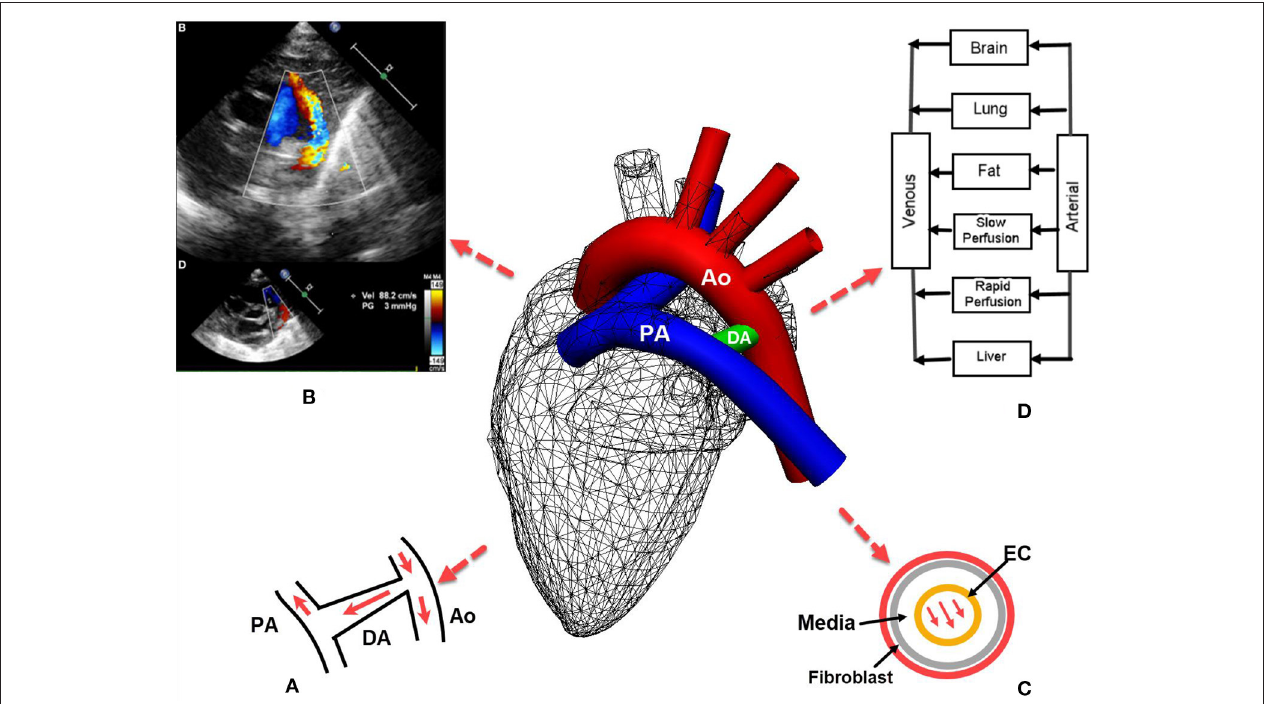
FIGURE 1 | Patent ductus arteriosus (PDA) in preterm infants: (A) the left-to-right or reversed flow in PDA after birth. Note the constriction where the DA joins aorta introduces high pressure gradient according to the Bernoulli’s equation; (B) echocardiography of PDA also reveals the pressure gradient between systemic and pulmonary circulations that aids hemodynamic modeling ( 4); (C) in silico models may be developed for the remodeling of different layers of the DA; (D) a typical pharmacokinetics model where blood flow rates are used to derive the drug amount in an organ. PA, pulmonary artery; Ao, Aorta; EC, endothelial